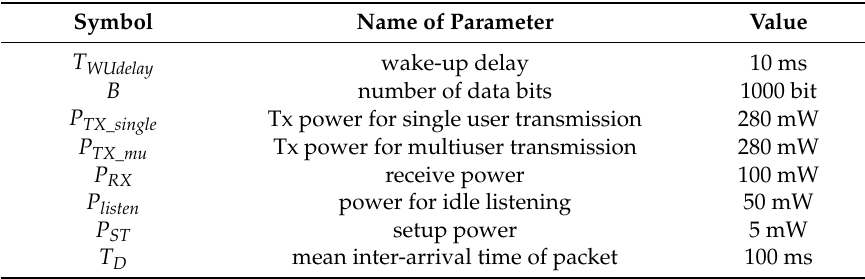
Table 2. Simulation Parameters. Tx =